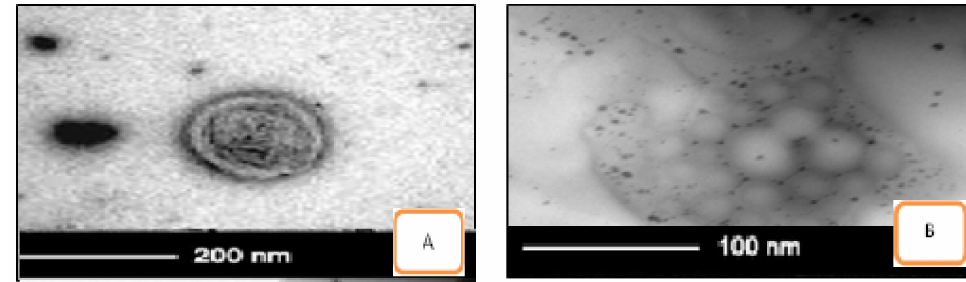
Figure 3. Transmission electron microscope (TEM) pictures of combination niosomes and niosomal gel ( A ) A+C-S60-C6 & ( B ) H-LV